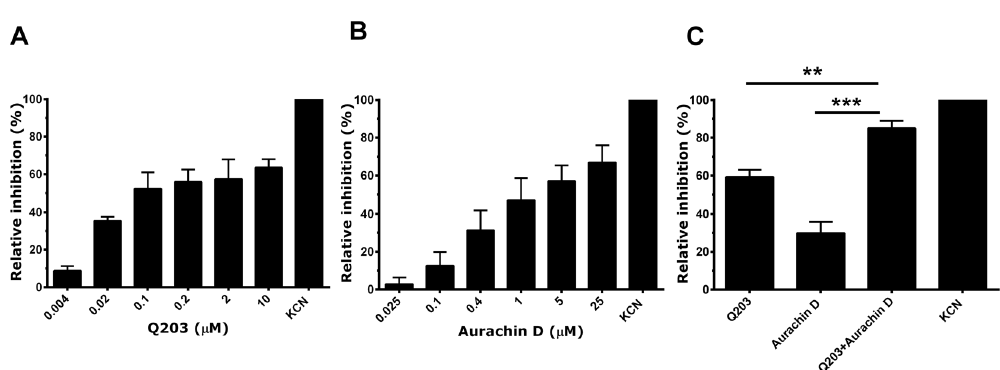
Figure 2. Inhibition of respiratory chain activity of M. tuberculosis by Q203 and aurachin D. The oxygen consumption activity of inverted membrane vesicles prepared from M. tuberculosis strain mc 2 6020 was determined using a Clark-type electrode. The activity in the absence of inhibitors was 95 nmol O 2 /min/mg protein. Shown is the concentration-dependent inhibition of oxygen consumption activity by Q203 (Panel A), aurachin D (Panel B), as well as inhibition by the combination of 10 μ M Q203 + 400 nM (0.14 μ g/ml) aurachin D (Panel C). ** and *** represent P < 0.01, and P < 0.001, respectively. Average values were calculated from three independent experiments, error bars represent standard deviations. Potassium cyanide (10 mM) was used as Inhibition of respiratory chain activity in M. smegmatis by Q203. Interestingly, the respiratory chain activity of IMVs isolated from M. smegmatis , a fast-growing mycobacterial strain that is not sensitive to growth inhibition by Q203 (MIC > 50 μ M) 12 , was also efficiently blocked by Q203 (Fig. 3A, black bars). The affinity of Q203 for the cytochrome bcc complex in M. smegmatis (IC 50 ~ 20 nM) was comparable to the affinity for M. tuber- culosis cytochrome bcc in the employed assay system, although M. tuberculosis and M. smegmatis vastly differ in drug susceptibility. These results demonstrate that the lack of growth inhibition found for M. smegmatis is not caused by insufficient affinity of Q203 for the cytochrome bcc complex in M. smegmatis . As observed for M. tuber- culosis , inhibition of respiratory chain activity of M. smegmatis IMVs by Q203 was incomplete (max. inhibition 50–80%, depending on membrane batch). IMVs isolated from an M. smegmatis strain lacking the cytochrome bcc complex 14 did not show significant inhibition of respiratory chain activity by Q203 (Fig. 3A, red bars), demonstrating the drug’s target specificity. In contrast, IMVs from a M. smegmatis strain lacking cytochrome bd 23 displayed 100% maximal inhibition by Q203 (Fig. 3A, grey bars), further supporting the interpretation that cytochrome bd can partially compensate for inactivation of the cytochrome bcc complex. As observed for M. tuberculosis , the 10 μ M Q203/400 nM aurachin D combination showed significantly stronger inhibition of M. smegmatis wild-type respiratory chain activity than 10 μ M Q203 alone (Fig. 3C). Consistent with these results, we found that genetic inactivation of cytochrome bd in M. smegmatis 23 decreased the MIC for Q203 from > 50 μ M to 2.5 μ M. Apparently, cytochrome bd mediates sensitivity for Q203 in both M. tuberculosis and M. smegmatis . However, the moderate sensitivity of the M. smegmatis bd -KO strain compared